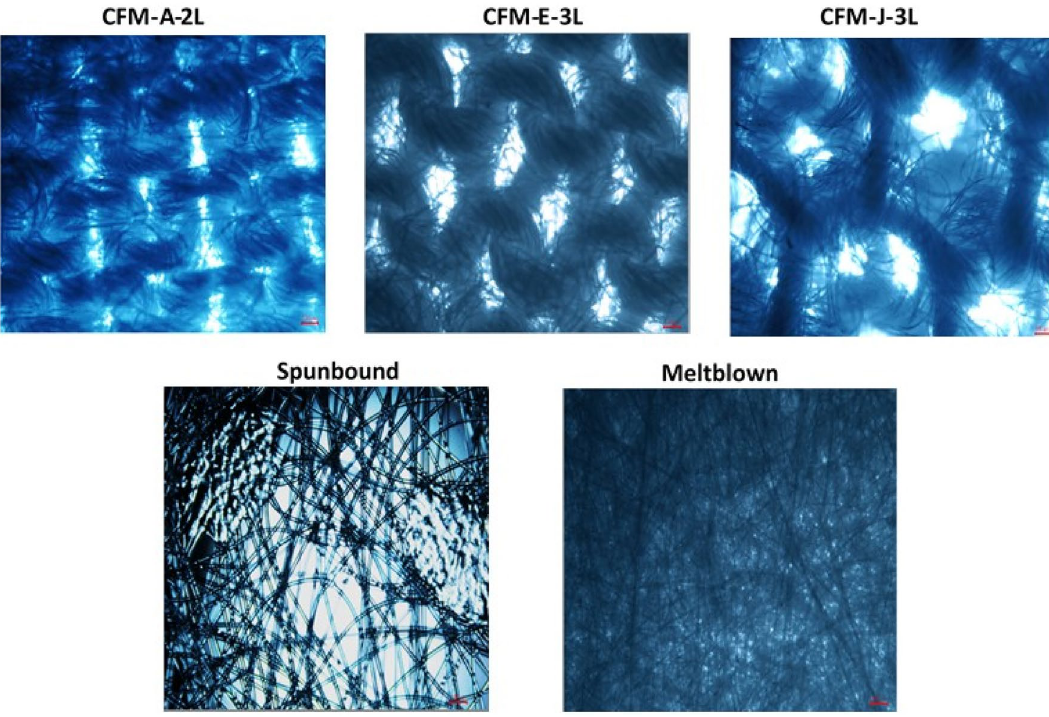
Figure 3. Optical microscopy images of the microscopic structure of 3 community face masks and the medical face mask. (4× magnification and red scale bar corresponds to 100 μm). Optical microscopy images of all CFMs are provided in supplementary